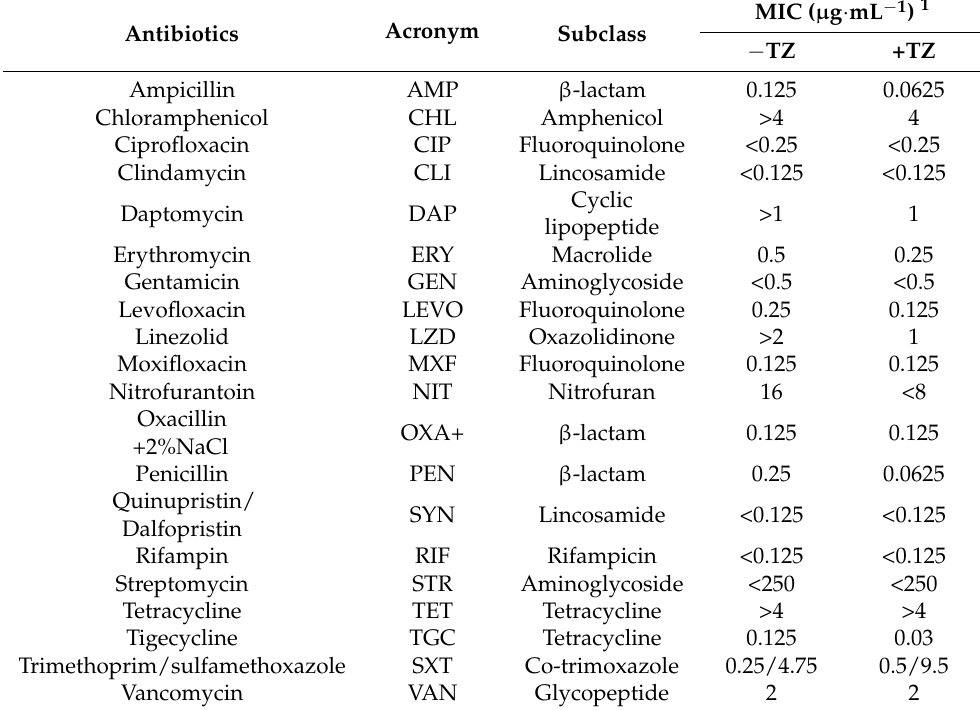
Table 2. Minimum inhibitory concentration (MIC) of antibiotics owing to TZ NC against the type S. epidermidis